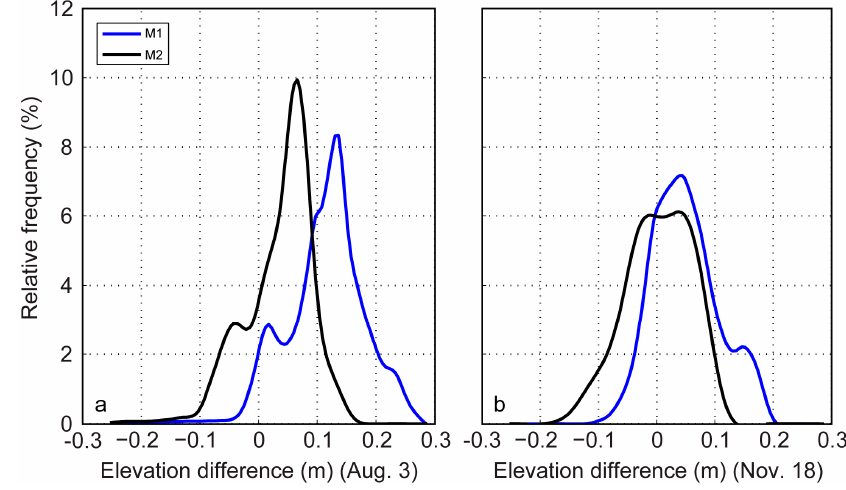
Figure 10. Relative frequency (%) of the Δ LiDAR- Z mwl (M1) and Δ LiDAR- Z twl (M2) digital elevation models’ (DEMs) differences (over all pixels) as observed during 3 August ( a ) and 18 November ( b ). Positive values indicate higher elevations on the LiDAR and underestimations by the shoreline detection model.